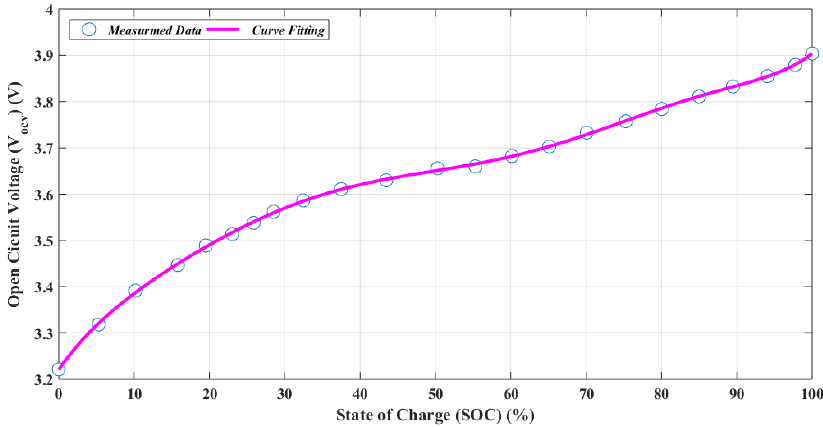
Figure 2. SOC and V ocv curve of Samsung ICR18650-26F lithium-ion battery at 27 ± 1 ◦ C. Figure 2. SOC and 𝑽 𝒐𝒄𝒗 curve of Samsung ICR18650-26F lithium-ion battery at 27 ± 1 °C. Table 1. Values of the polynomial Coefficients of the SOC-OCV Table 1. Values of the polynomial Coefficients of the SOC-OCV function.